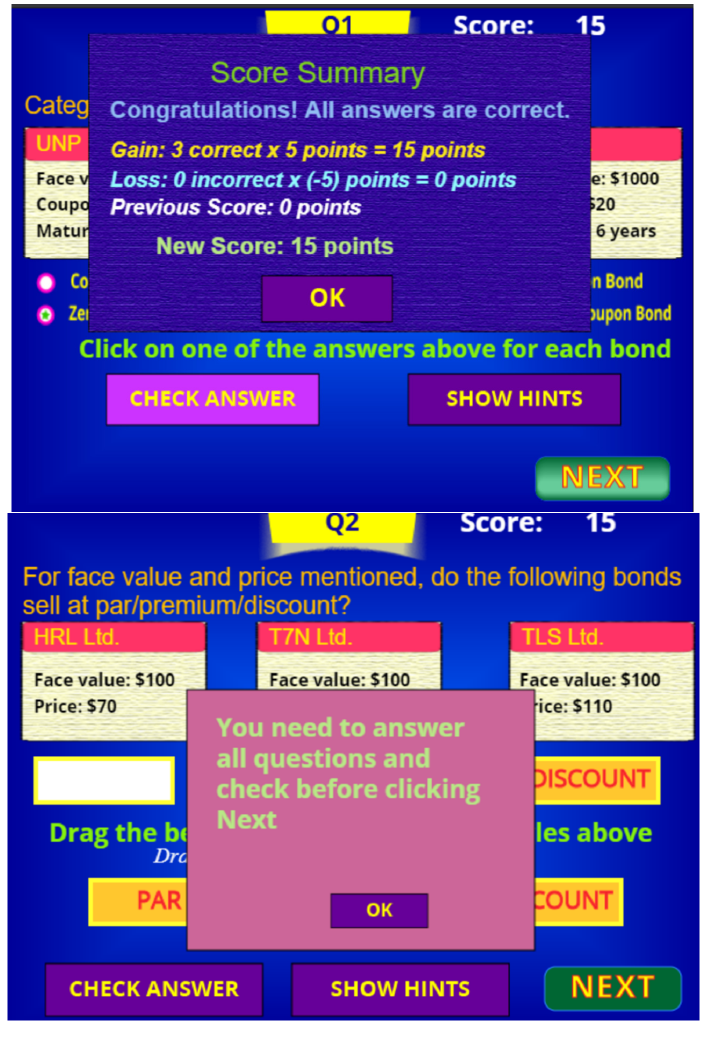
Figure 2. Example error screen.